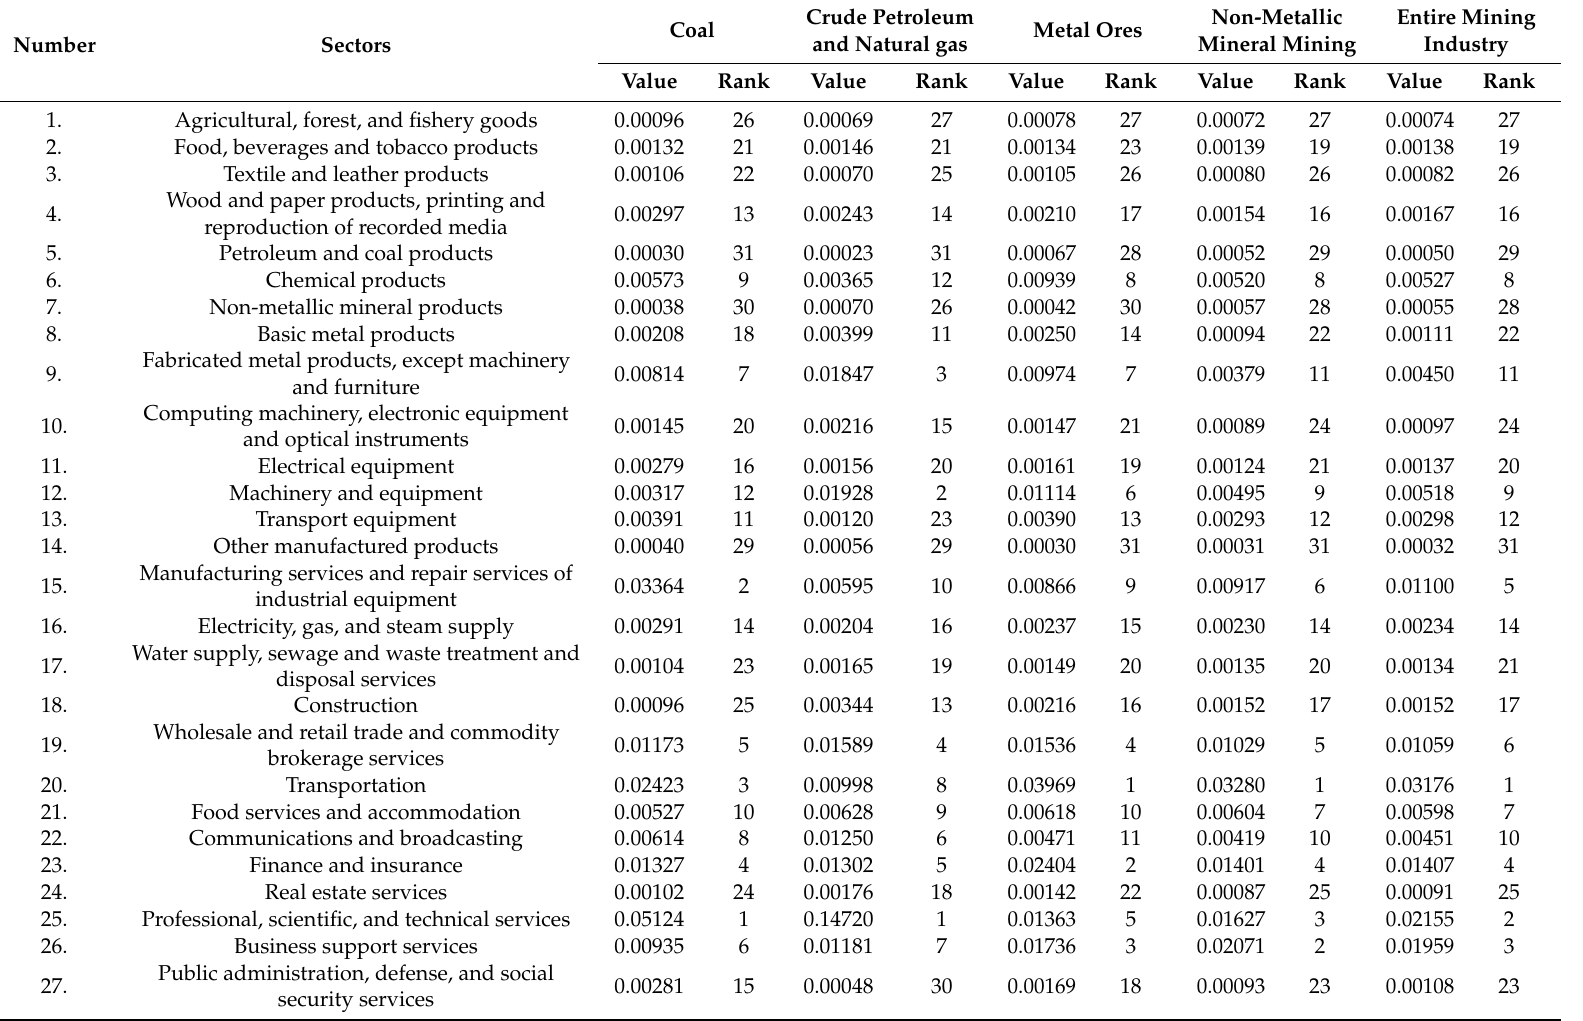
Table 4. Wage-inducing e ff ects of mining